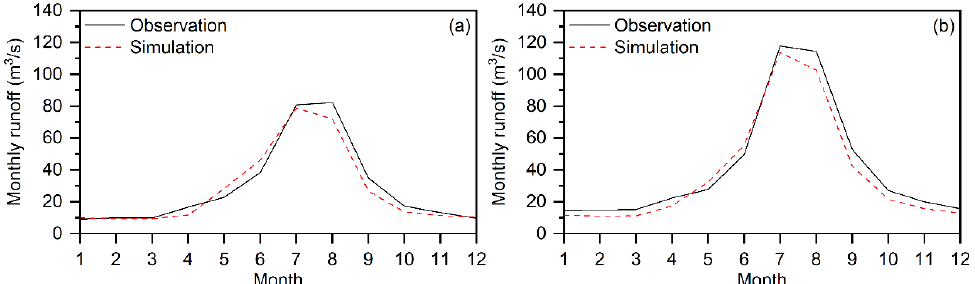
Figure 7. Comparison of the simulated and observed monthly mean amounts of runoff for the calibration period from 1971 to 1990 and validation period from 1991 to 2020. ( a ) Calibration period; ( b ) Validation period.